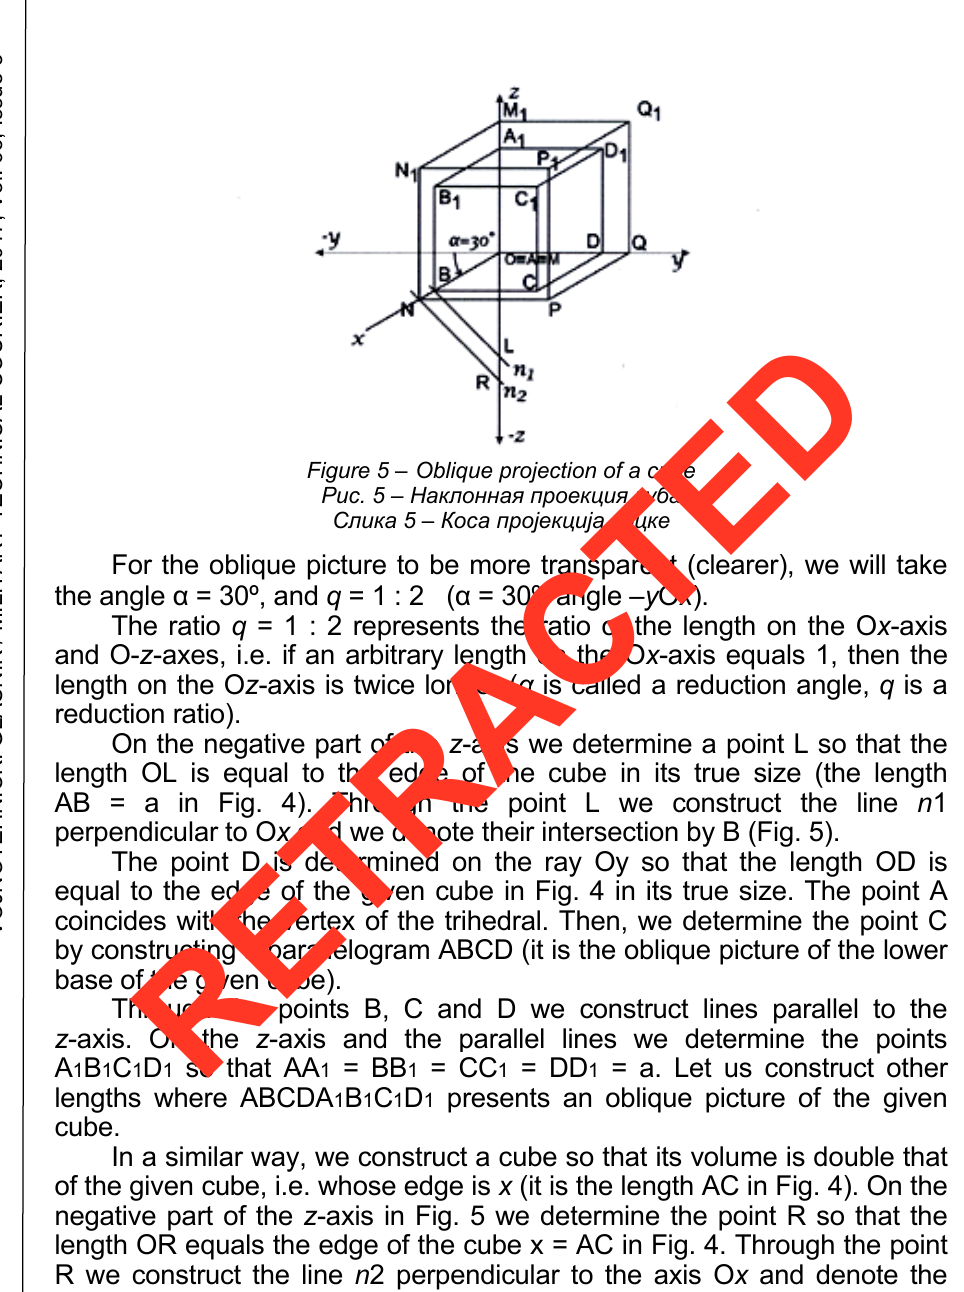
Figure 5 – Oblique projection of a cube Рис . 5 – Наклонная проекция куба Слика 5 – Коса пројекција